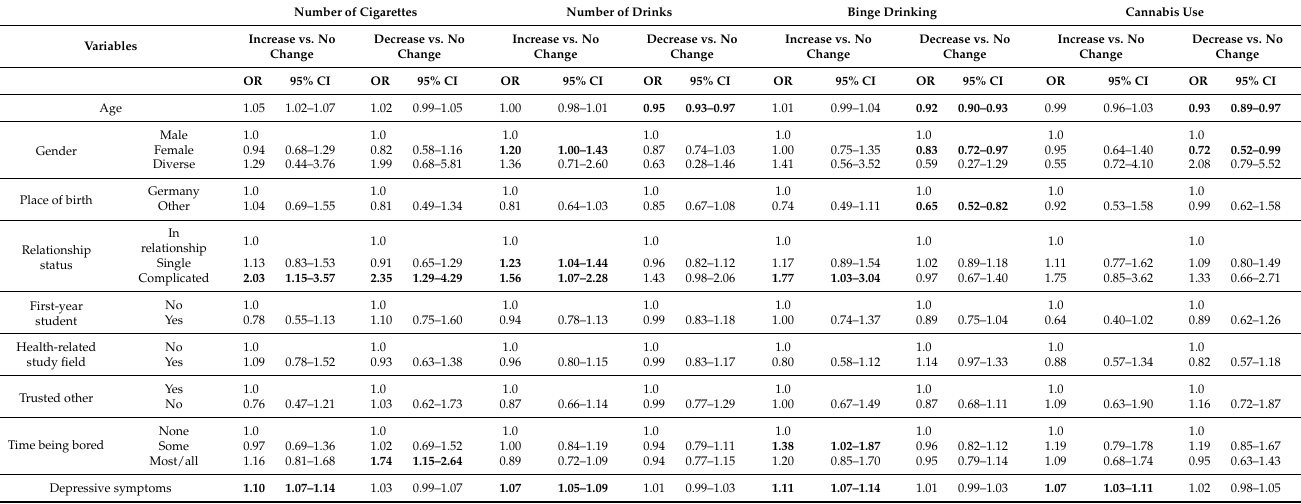
Table 4. Associations between change in risk behavior and age, gender, place of birth, relationship status, being a first-year student, study field, trusted other, boredom as well as depressive symptoms—Results of multinomial logistic regressions (ORs and 95%